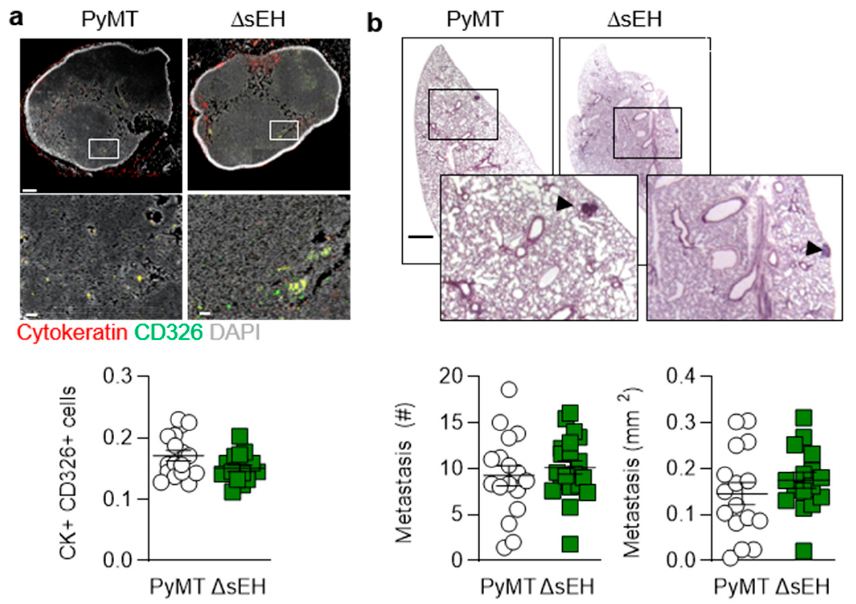
Figure 1. Consequences of sEH deletion on primary tumor growth. ( a ) Time-dependent increase in tumor number per animal from weeks 13 to 20; n = 8–13 animals per group. ( b ) Tumor volume per animal/week from weeks 13 to 20; n = 8–13 animals per group. ( c ) Total tumor weight at week 20; n = 13–19 animals per group. ( d ) Tumor burden (total tumor weight normalized to body weight) at week 20; n = 13–19 animals per group. * p < 0.05, ** p < 0.01, *** p < 0.001 (( a , b ) ANOVA for repeated measures and Newman–Keuls test, ( c , d ) Student’s t test).